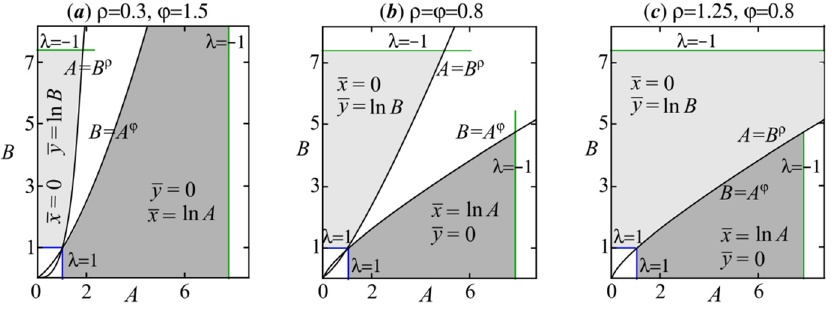
Figure 1. Stability domains of semi-trivial fixed points (6) and (7) with different values of ρ and φ .